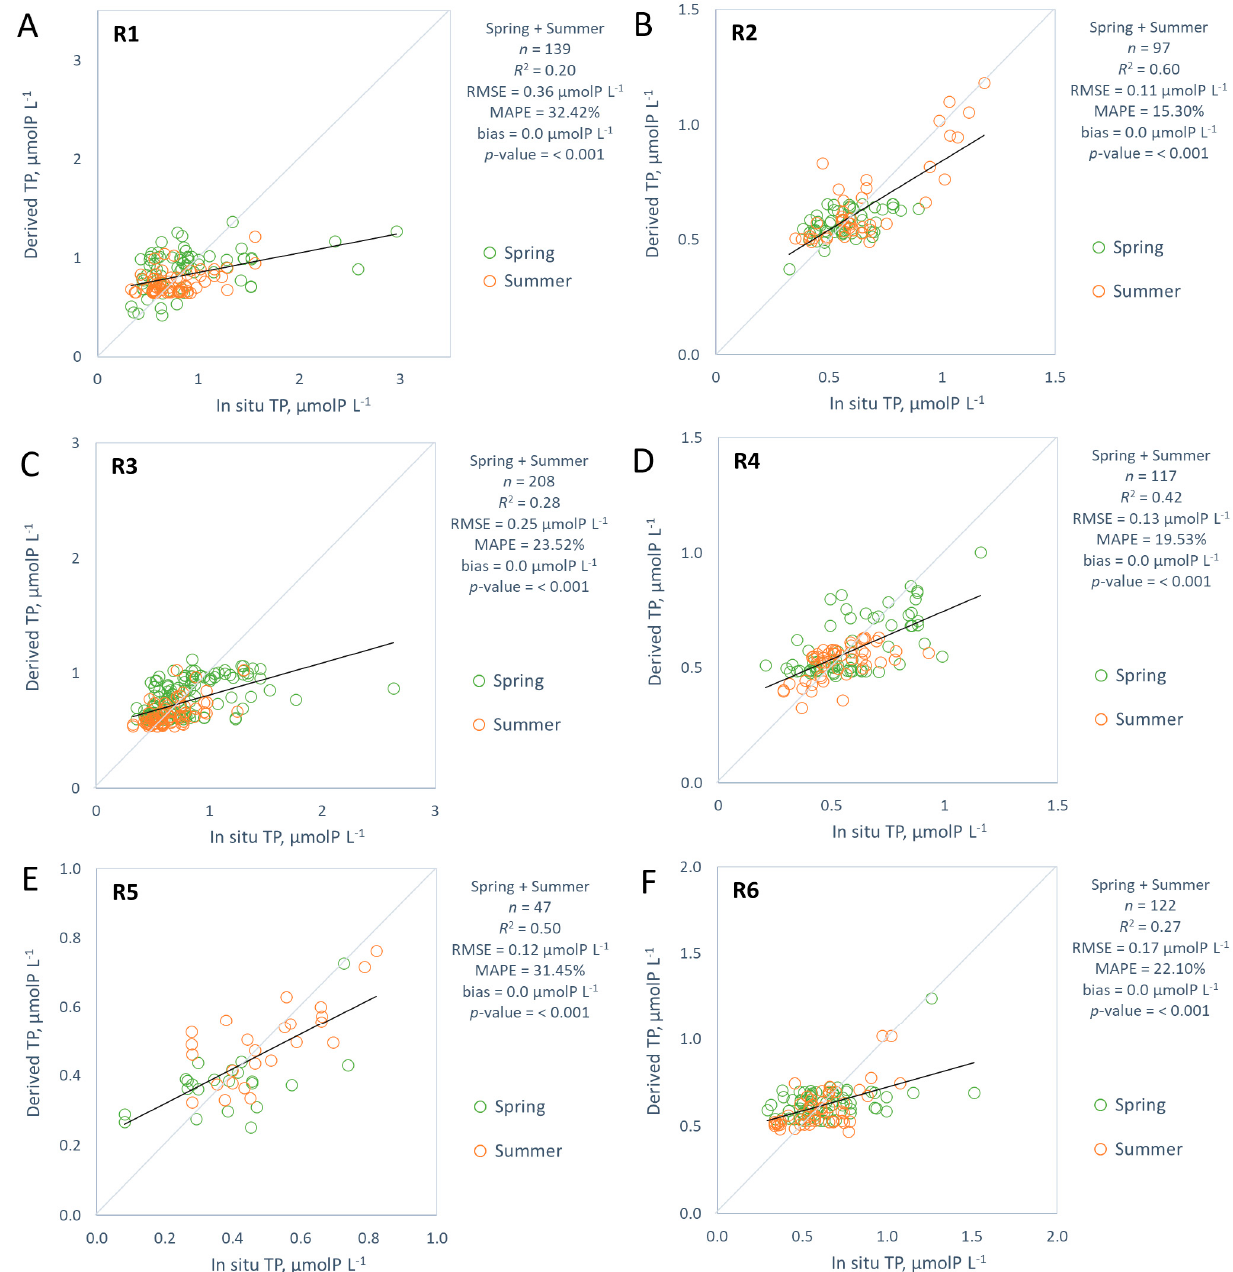
Figure 7. The comparison of the derived total phosphorus (TP, µ molP L -1 ) with in situ TP in each region of Estonian marine waters ( A-F ). The statistics on the right and the linear regression trendline (black line) are combined periods of spring (April to June: green rings) and summer (July to Sep- tember: orange rings).